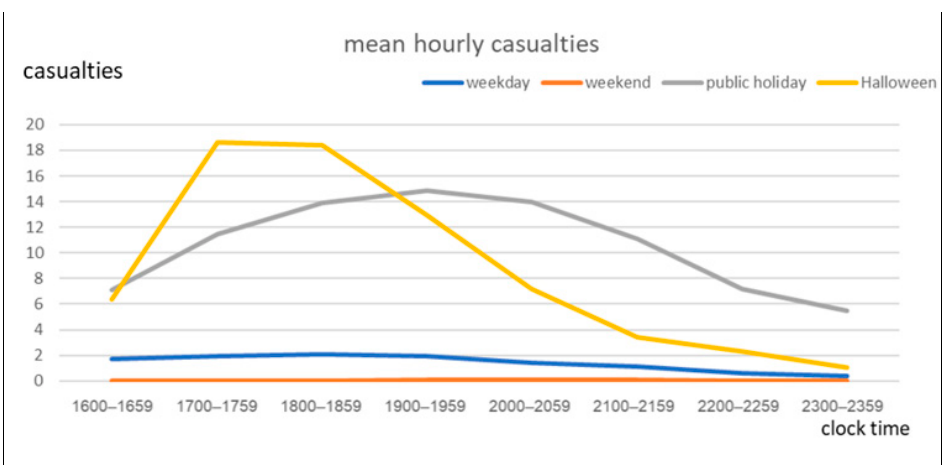
Figure 1. Mean hourly casualties by type of day.